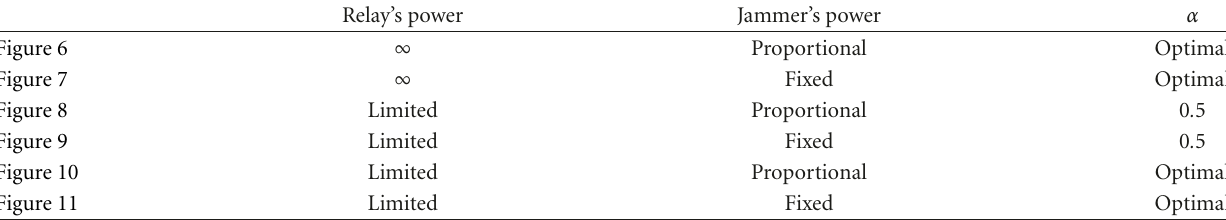
Figure 12: Equivalent channel model. Table 1: Scenarios considered in the numerical